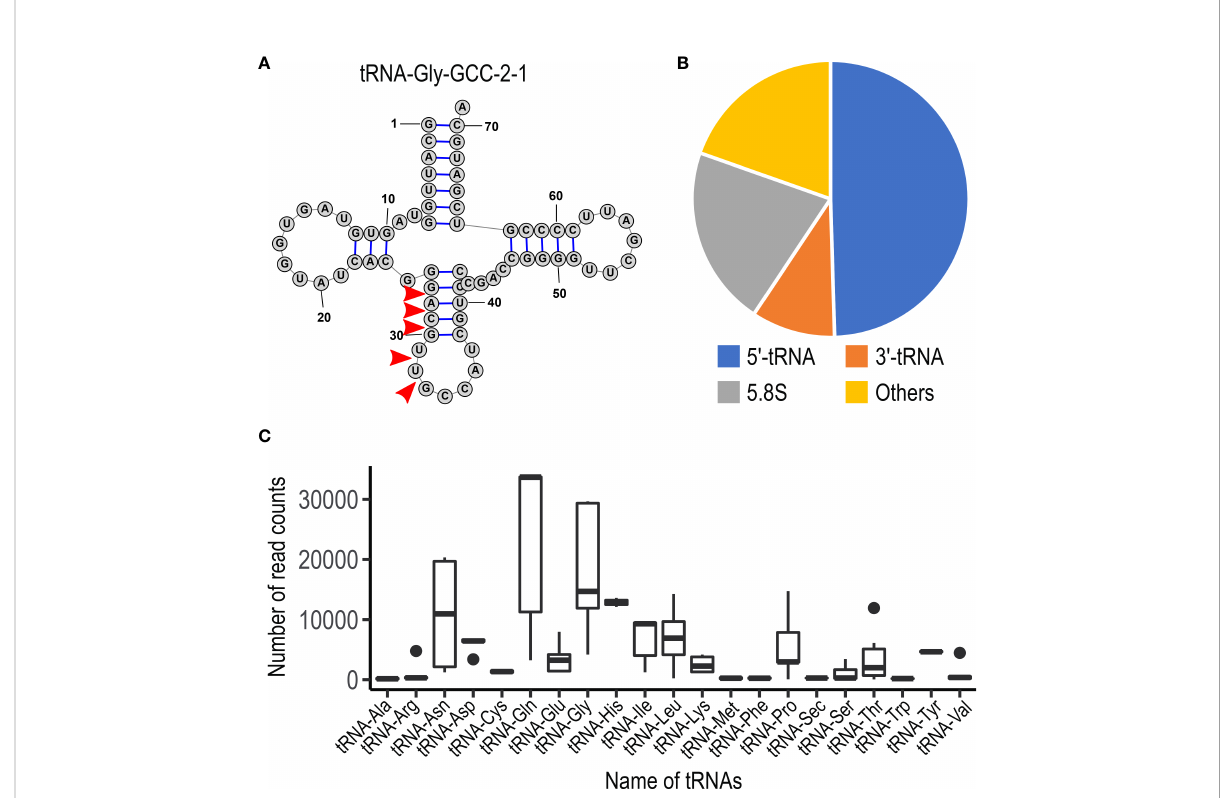
FIGURE 2 Characteristics of small non-coding RNAs in U. maydis . (A) Schematic picture of the structure for tRNA-Gly (GCC-2-1) in U. maydis . Red arrow heads indicate the putative cleavage sites, which are predicted from the sequence reads obtained by RNA-seq analysis. The numbers indicate the position of nucleotides from 5 ’ end of tRNA-Gly. (B) Pie chart showing the proportion of the type of small non-coding RNAs in U. maydis . (C) Box plot showing the number of sequence read counts derived from respective tRNAs. Dots represents outside values in each box